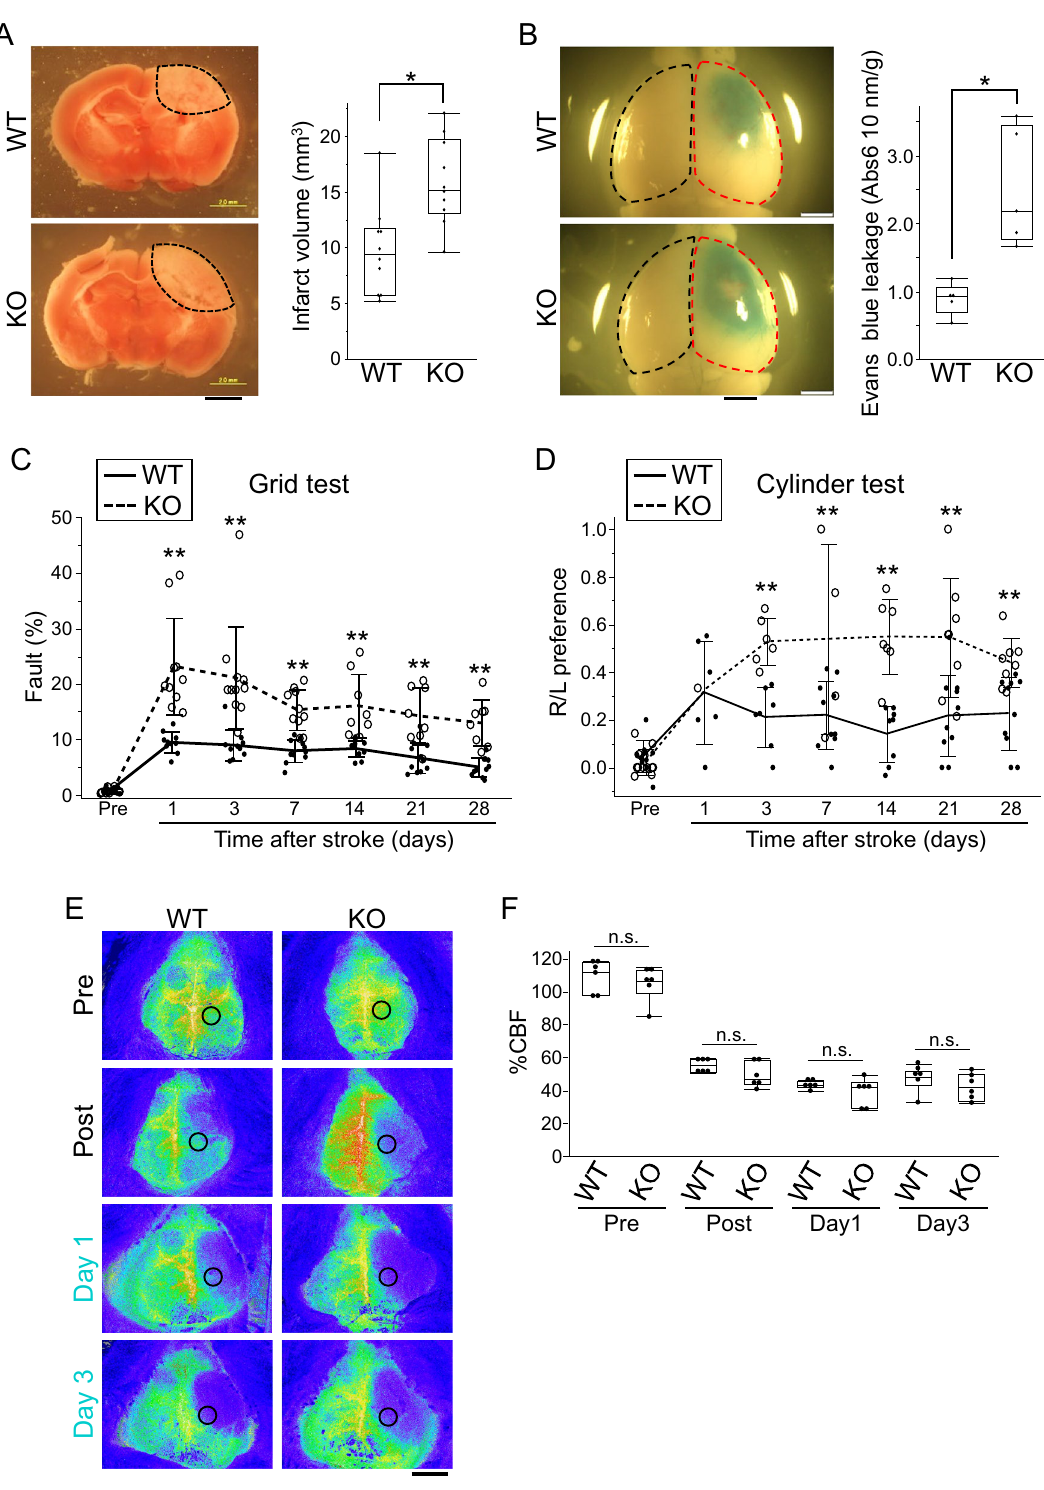
Figure 3. Increased infarction volume and leakage and deteriorated neurological function in occludin-deficient mice. In the acute phase, the infarct volume ( A ) is larger in wild-type mice(n = 10) than in occludin-deficient mice(n = 10). The infarct volume of the area indicated by the black dotted line in A was quantified. Leakage of Evans blue ( B ) is higher in occludin-deficient mice (n = 5) than in wild-type mice (n = 5). Evans blue leakage was quantified in the infarcted hemisphere shown by the red dotted line and in the non-infarcted hemisphere shown by the black dotted line ( B ). The motor function of occludin-deficient mice (n = 12) was worse than that of wild- type mice (n = 13) in the grid test ( C ) and the cylinder test ( D ) from the acute to the chronic phase. The cerebral blood flow (CBF) images are shown in ( E ), and the box and whiskers with max and min of CBF is shown in ( F ). CBF was similar at each time point between wild-type mice and occludin-deficient mice. CBF was quantified in the area indicated by the black circle ( E ). An unpaired t-test was performed. * P < 0.05. Scale bar = 2